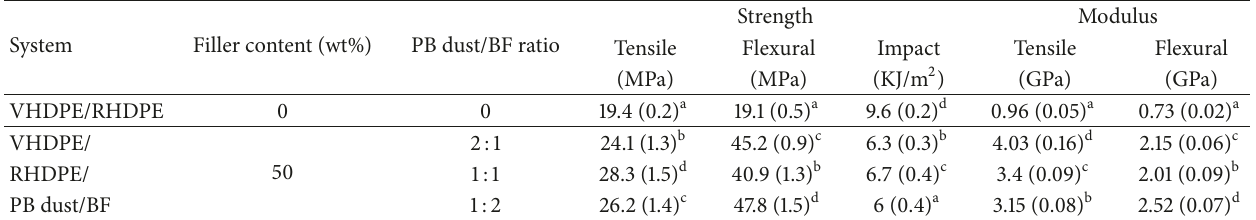
Table 3: Mechanical properties of HDPE and filled HDPE composites with combined fillers. System VHDPE/RHDPE